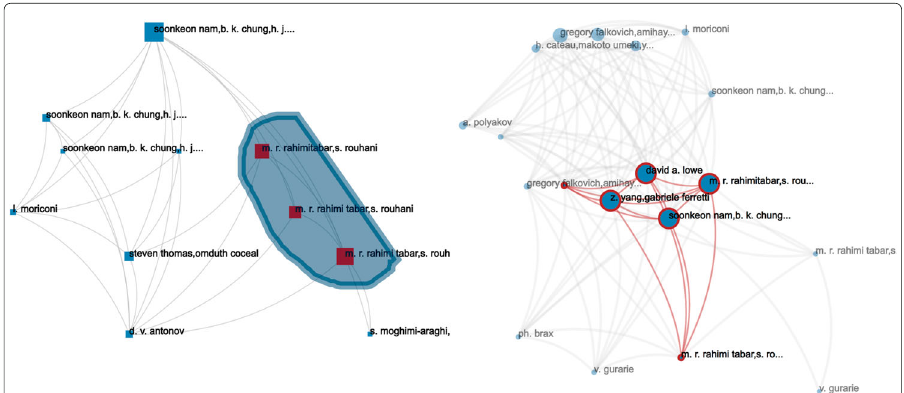
Fig. 17 Detangler (Renoust et al. 2015) view of the subgraph induced by ID9303050 (sum flow). On the left the citation network (size is the sum flow), on the right the layer network (size is the entanglement index). Nodes are labeled with their authors’ name. The topology of the layer network suggests two intertwined communities ( top and bottom ). In the citation network ( left ) we select the three citing articles authored by the same group (with high sum flow). The corresponding co-cited articles (shown on the right ) display four main cited articles (and two marginal ones). Only one of the main is a self-citation — and one marginal as